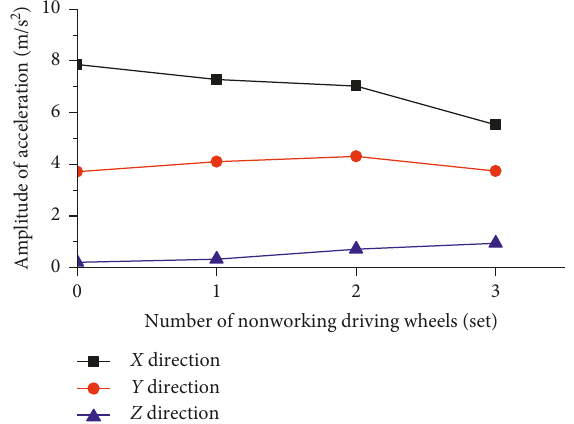
value vs. (a) the working v